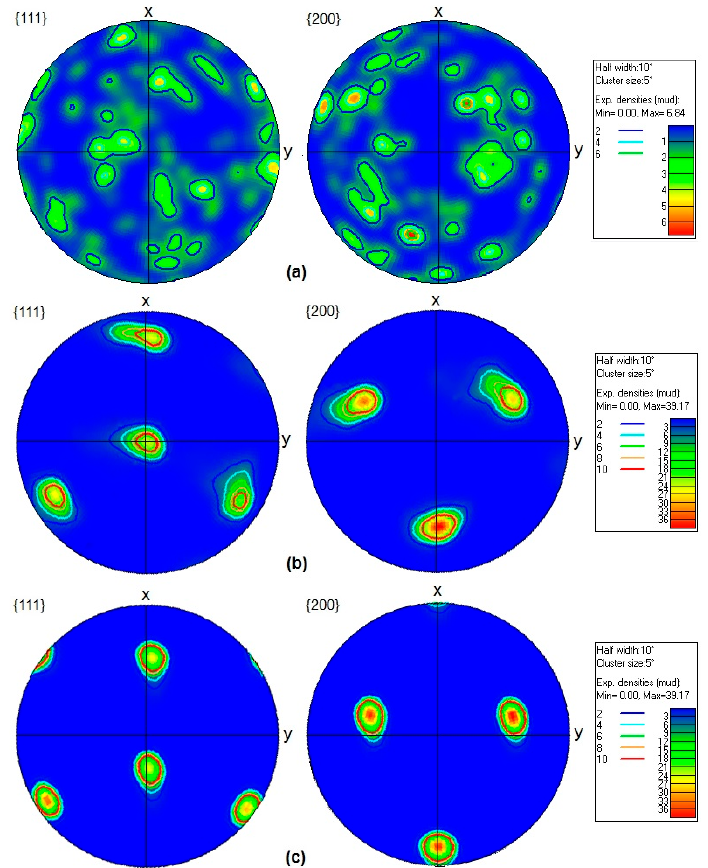
Figure 13. {111} and {200} pole figures of the solution ‐ treated AA ‐ 6063 alloy: ( a ) before ( b ) and ( c